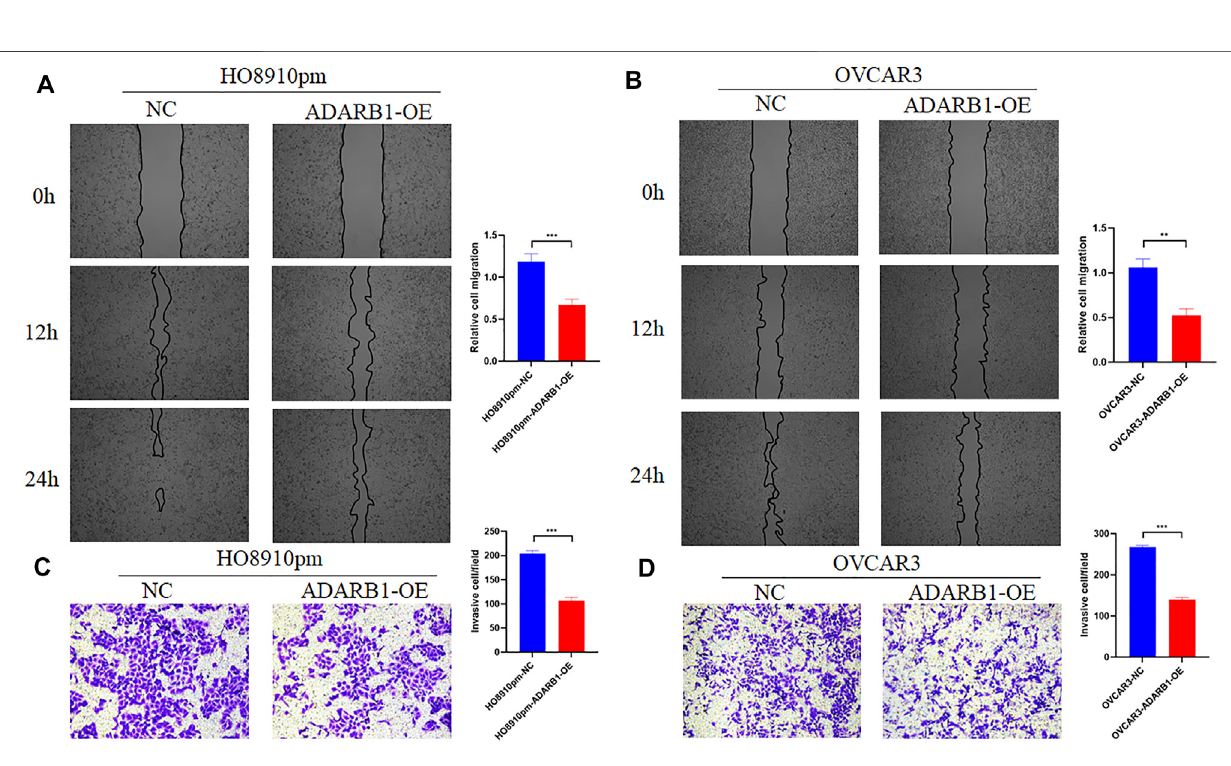
Frontiers in Bioengineering and Biotechnology |